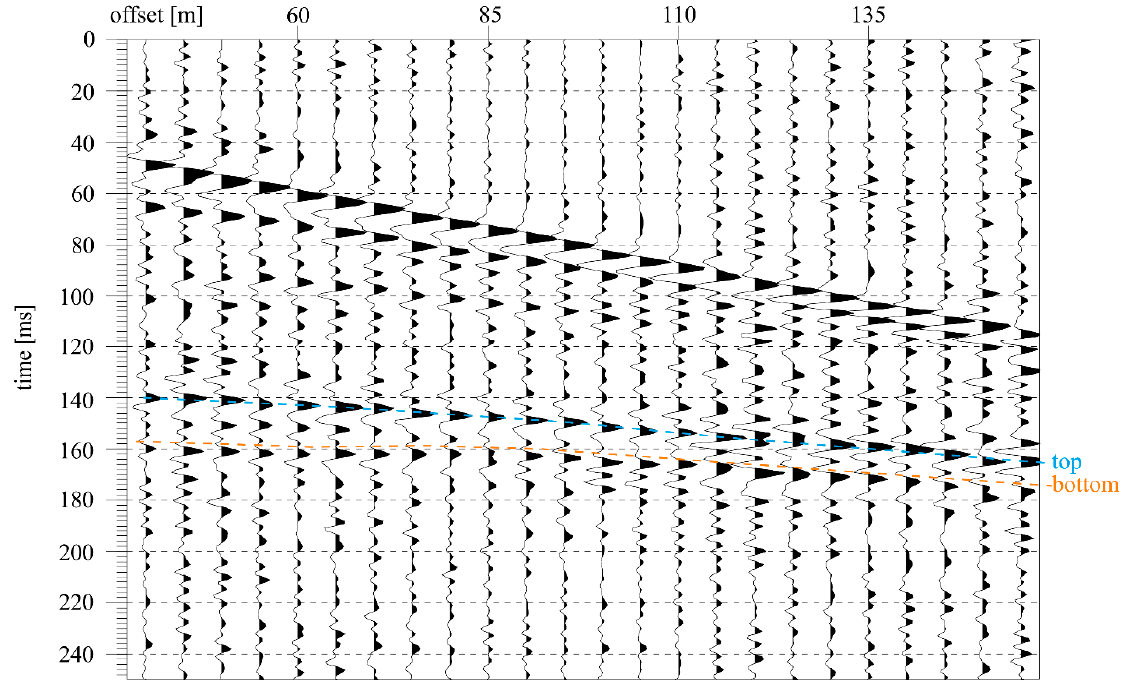
Figure 8. Exemplary shot record after trace normalization (for display purposes only). Due to the high quality of the acquired data, reflections from top and bottom of the deposit can be unequivocally identified. They occur at 140 and 160 ms, respectively, and are characterized by high amplitudes compared to other reflections.